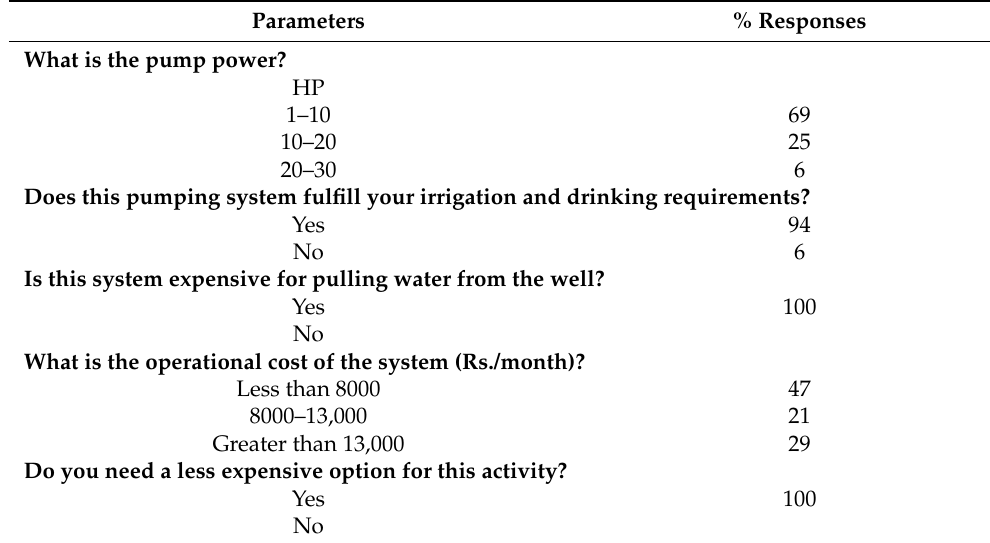
Table 7. Diesel-operated pump for water uplifting from dug